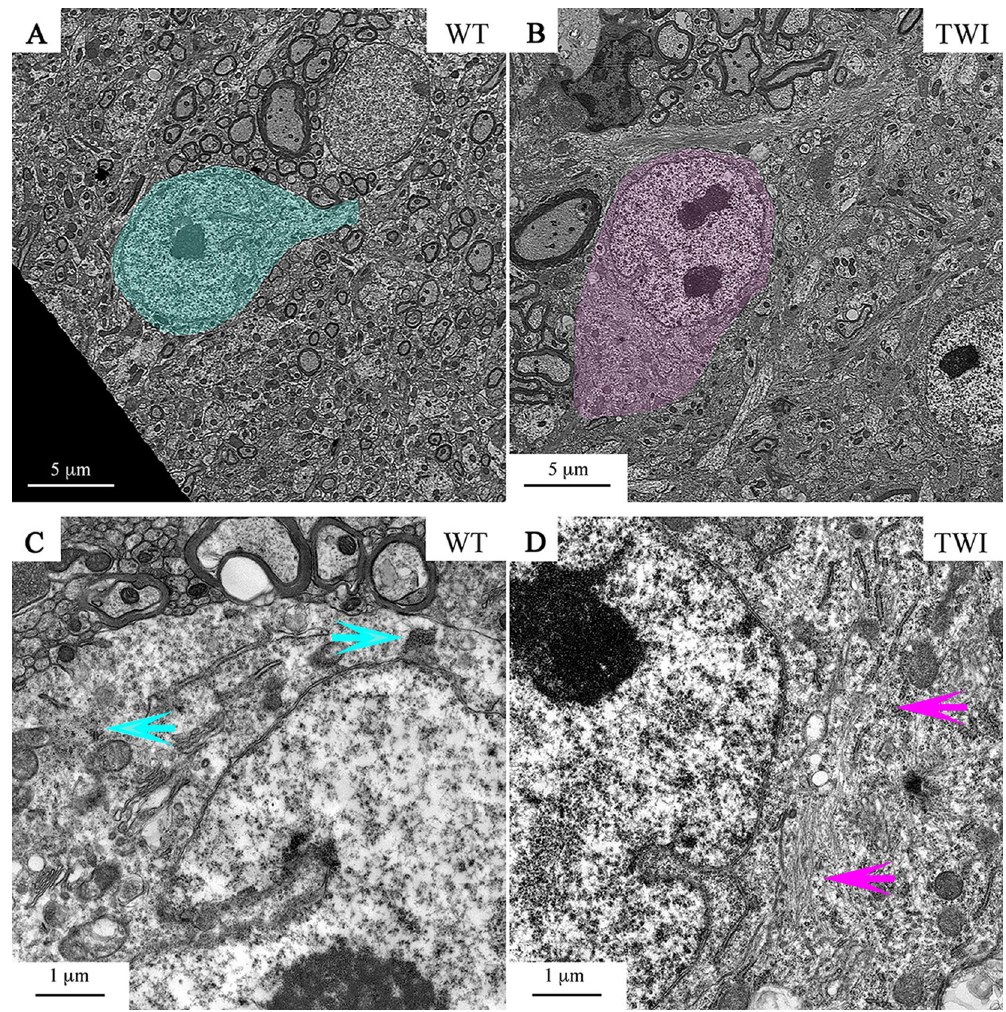
Figure 4. P30 motor neuron bodies in spinal cord. ( A,B ) MNs bodies (painted) in the spinal cord of WT and TWI. ( C,D ) Higher magnification of perinuclear regions of WT and TWI MNs. Arrows indicate normal ( C ) versus altered ( D ) actin cytoskeleton